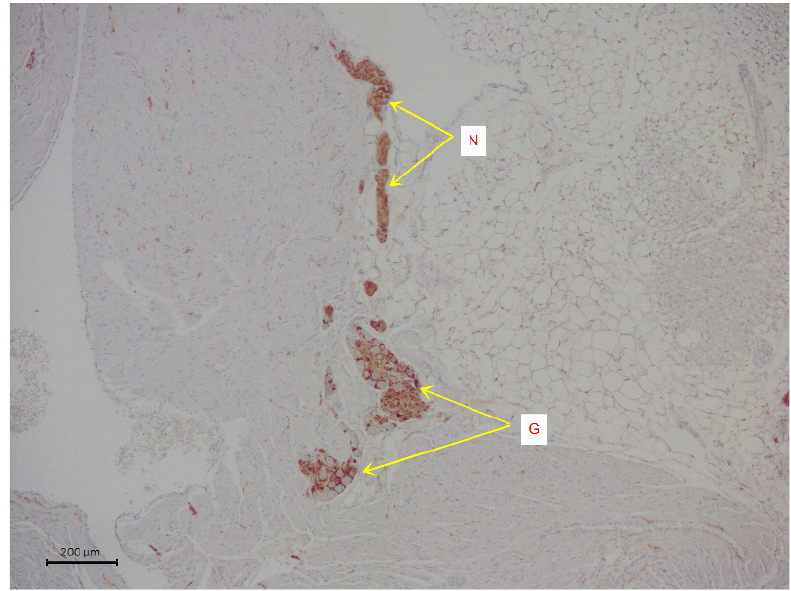
Figure 1. A representative image of intramural neural structures of rat right atrium. The arrows indicate parasympathetic nerve ganglion (G) and parasympathetic neural fibers (N). Immunohisto- chemical analysis on S100 b.